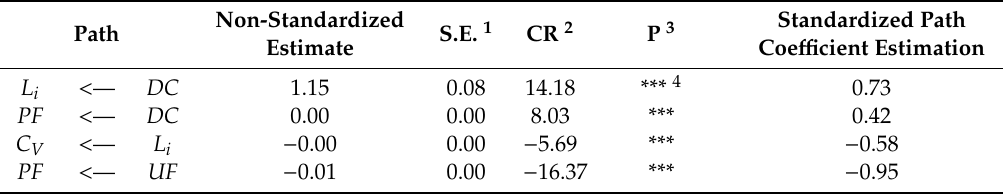
Figure 5. SEM of preferential flow characteristic parameters (e represents the errors). Table 4. Regression results of SEM variables.